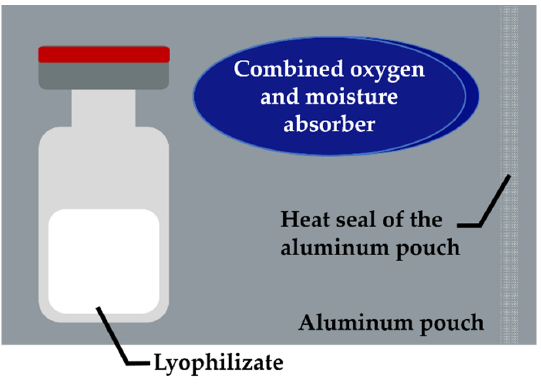
Figure 1. Illustration of the smart packaging system with combined oxygen and moisture absorber. Each pouch was equipped with one absorber and one vial containing the lyophilizate and heat sealed under ambient conditions.